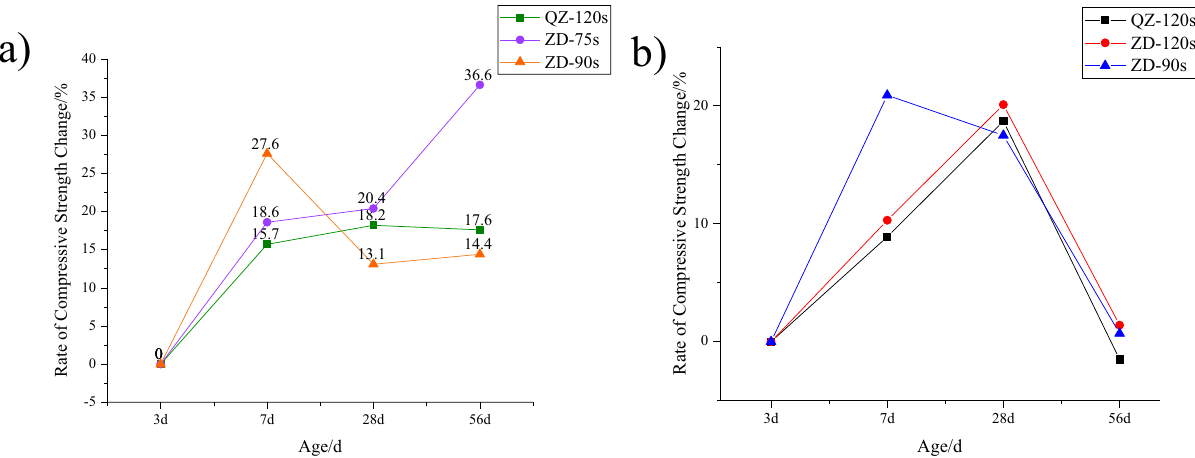
Figure 10: The change rate of concrete strength. ( a ) C40 concrete strength change rate. ( b ) C60 concrete strength change rate compared to the 3